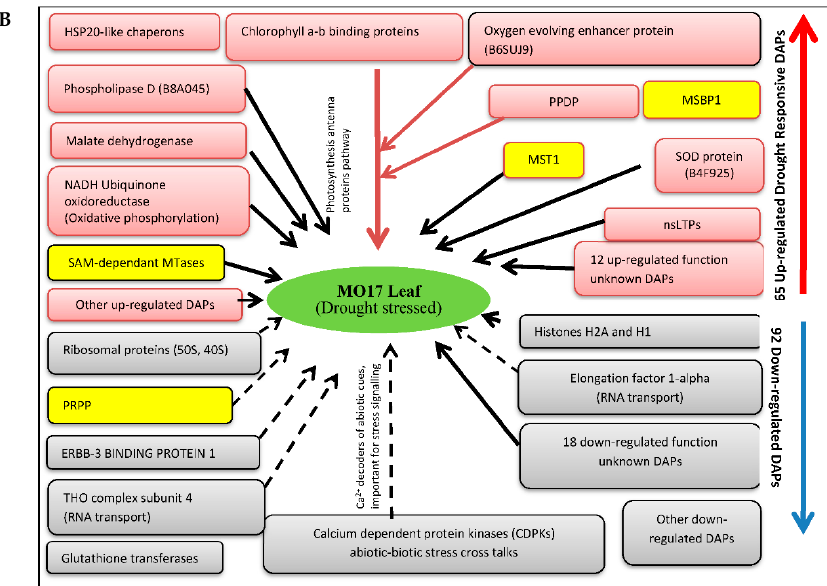
Figure 9. Molecular models of drought tolerance in maize seedling leaves of: ( A ) tolerant inbred line YE8112 and ( B ) sensitive line MO17. Red nodes (rectangles/circles) signify up-regulated DAPs; gray nodes signify down-regulated DAPs; yellow nodes in MO17 model (Figure 9B) represents overlapping DAPs also observed in YE8112. Dotted black connectors/arrows imply drought stress imposed negative effects on respective proteins or pathways; compound type black connectors imply desirable drought stress response outcomes on respective proteins. Note: nsLTPs, non-specific lipid transfer proteins; GDPD5, Glycerophosphodiester phosphodiesterase 5; MSBP1, membrane steroid binding protein 1; MAPK, mitogen-activated protein kinases; PRPP, Ribose-phosphate pyrophosphokinase; MST1, monosaccharide transporter 1; PPDP, pyruvate phosphate dikinase proteins.